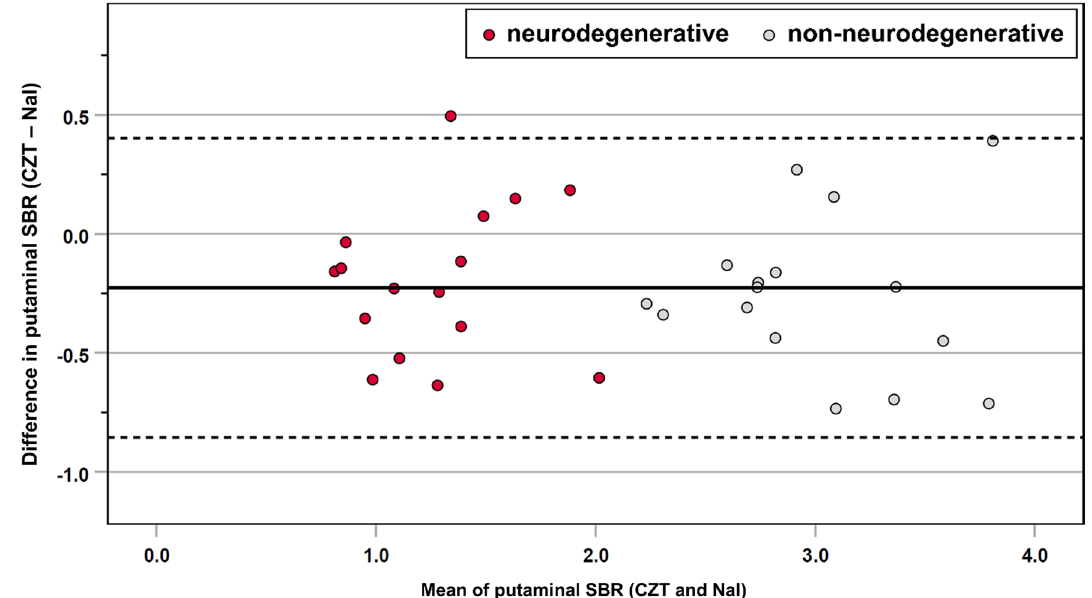
Fig. 2 Bland–Altman plot for putaminal SBR between the CZT and NaI camera system in the crossover group. Subjects visually rated as neurodegenerative PS are indicated by red dots, subjects visually rated as non-neurodegenerative PS by gray